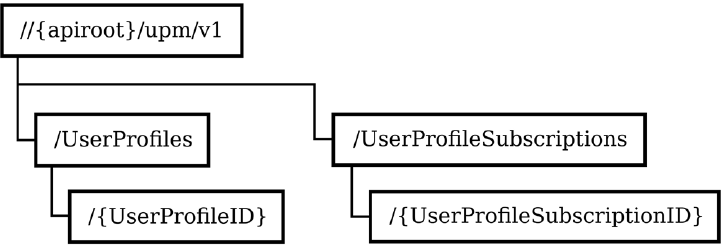
Figure 3. Structure of the URIs of the UPM service resources.